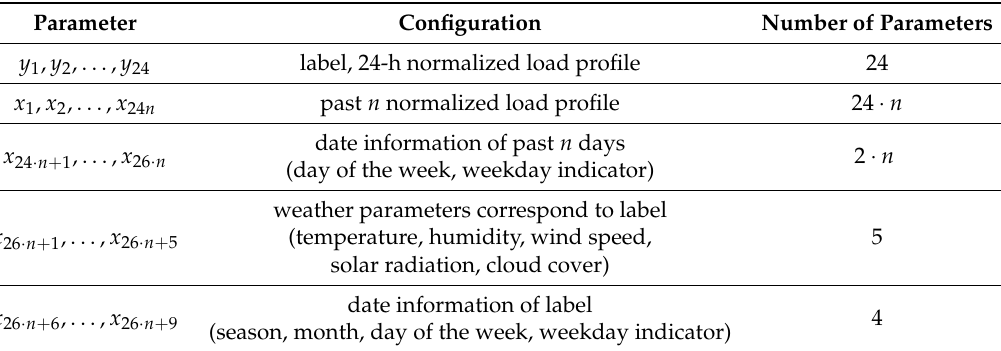
Table 1. Training data